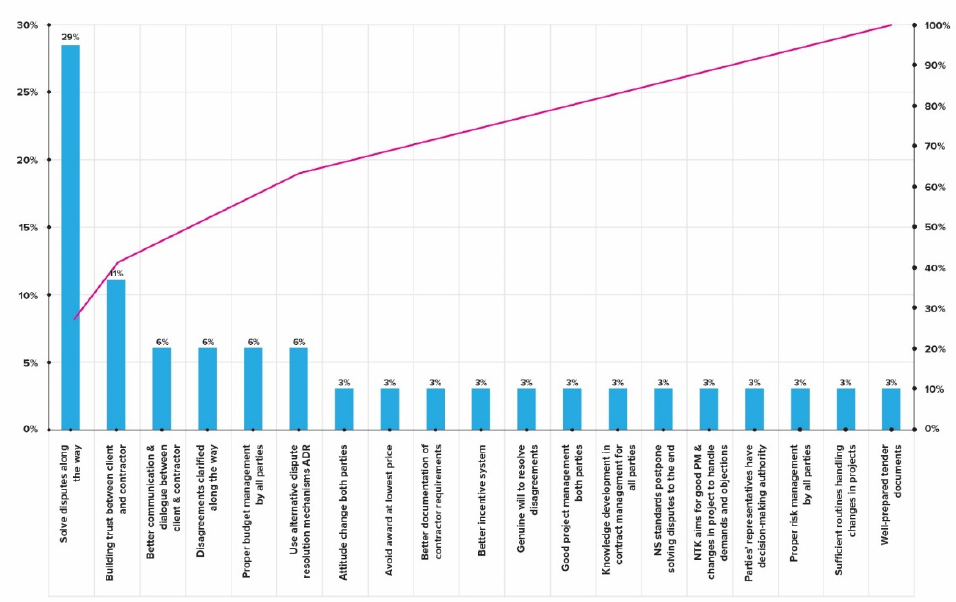
Figure 9. Pareto diagram showing disputes prevention techniques related to final settlement—payment related.